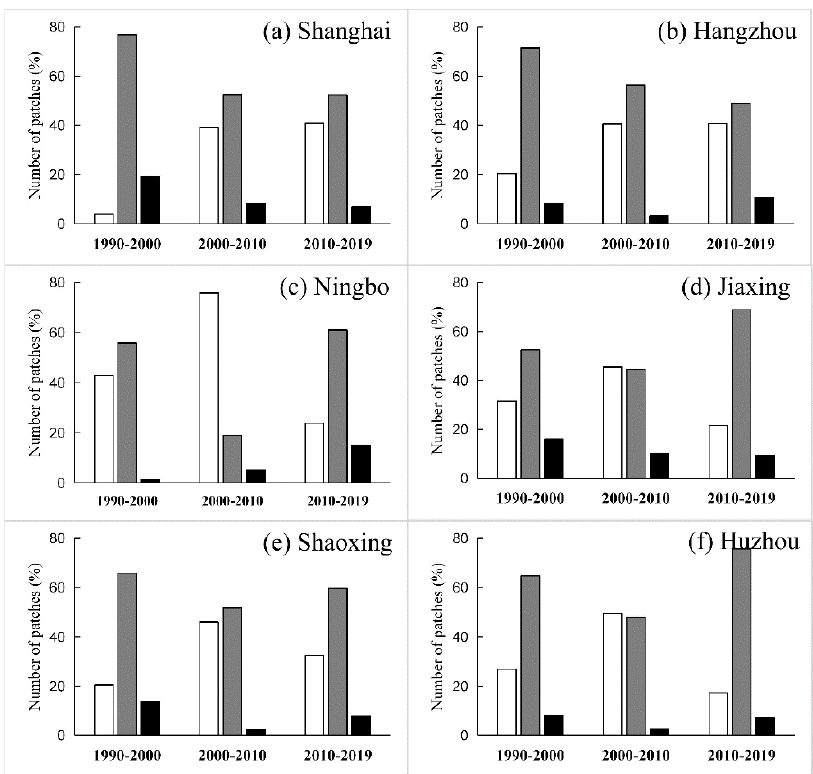
Figure 5. Composition of urban expansion forms in SHB from 1990 to 2019: ( a ). Shanghai; ( b ). Hangzhou; ( c ). Ningbo; ( d ). Jiaxing; ( e ) Shaoxing; ( f ) Huzhou.